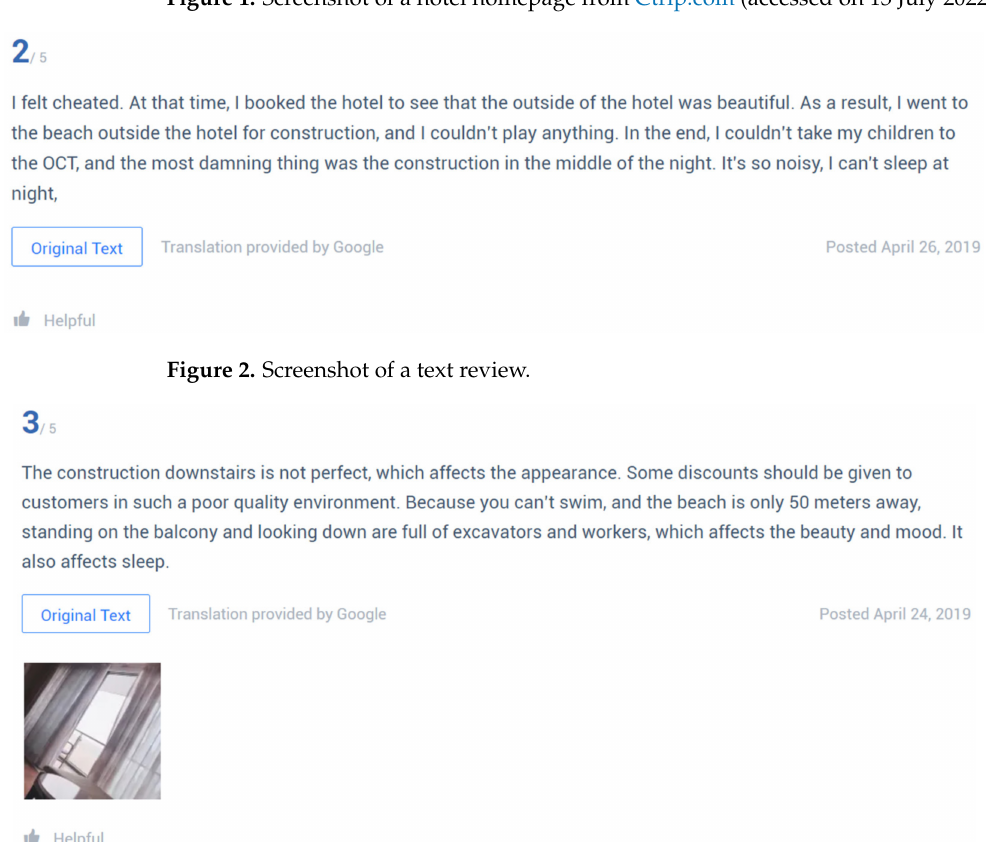
Figure 1. Screenshot of a hotel homepage from Ctrip.com (accessed on 13 July 2022).